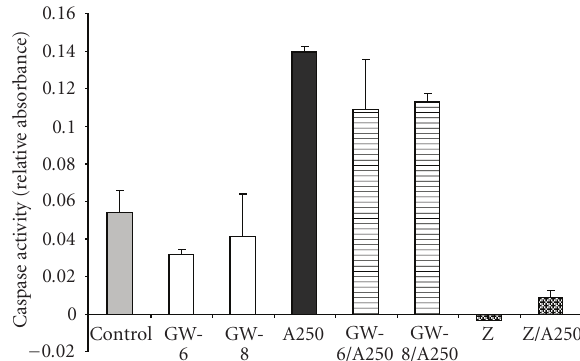
Figure 9: Anisomycin increases caspase activity in IMCD-K2 cells, independent of GW501516. Serum-starved cells were treated with serum-free media (control) for 24 hours, 250 ng/mL anisomycin (A250) for 24 hours, 10 − 6 M GW501516, and 10 − 8 M GW501516 for 24 hours pretreatment followed by 10 − 6 M and 10 − 8 M GW501516 for 24 hours with (GW-6/A250 and GW-8/A250) or without anisomycin (GW-6 and GW-8), Z-VAD-FMK, a pan- caspase inhibitor with (Z/A250) or without (Z) anisomycin. Values are mean ± S.E.M.